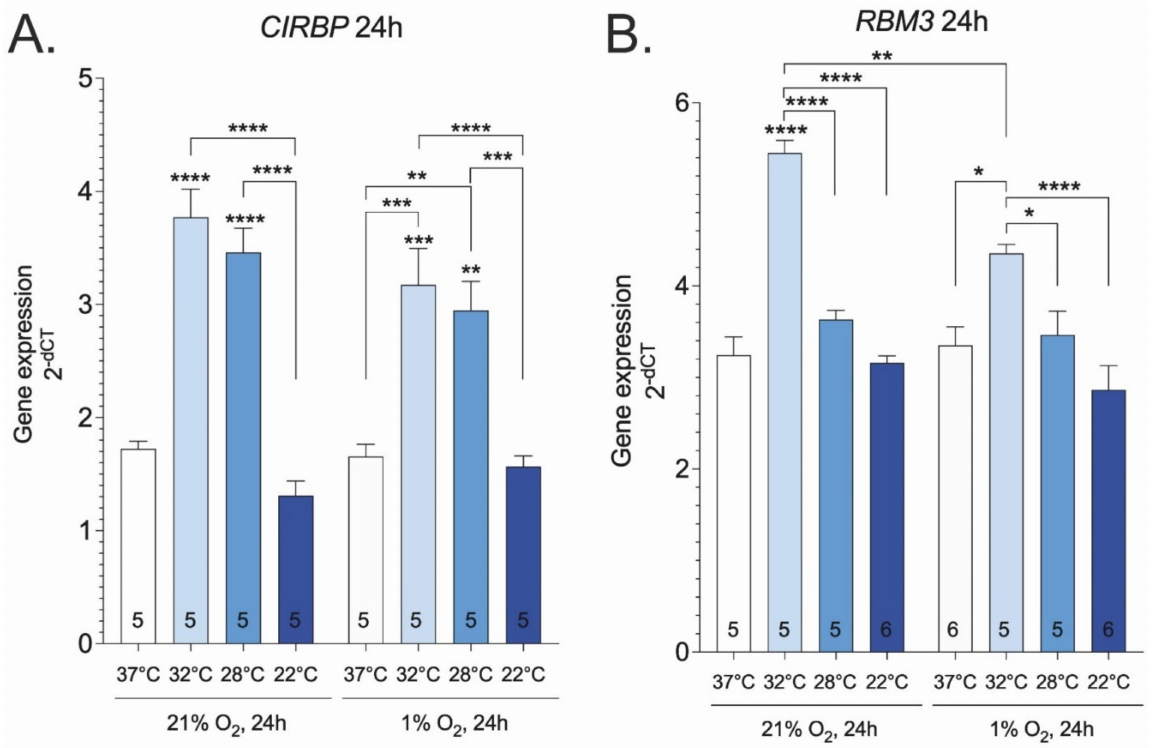
Figure 1. Cirbp ( A ) and Rbm3 ( B ) gene expressions at various temperatures and oxygen concen- trations. Asterisks refer to a statistically significant difference with respect to 37 ◦ C control unless indicated otherwise. Numbers in bars indicate sample size. Values are expressed as mean ± SEM. Statistical analysis was performed with One-way ANOVA with post-hoc Tukey HSD Test. *, p < 0.05; **, p < 0.01; ***, p < 0.001; ****, p <